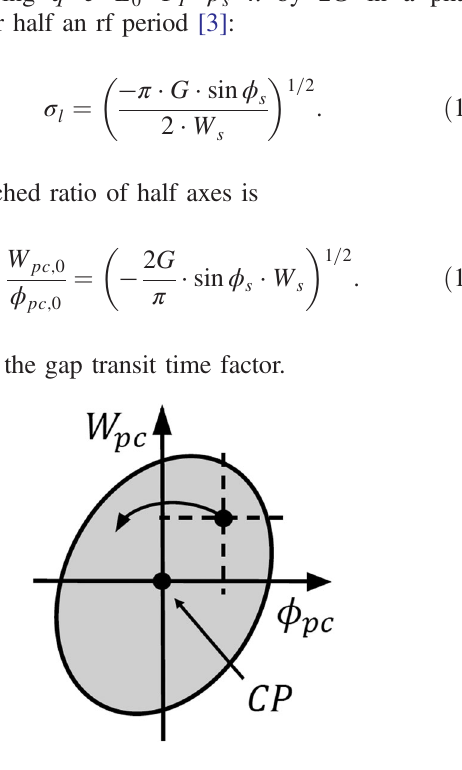
FIG. 12. Scheme of the single-particle motion around the bunch center